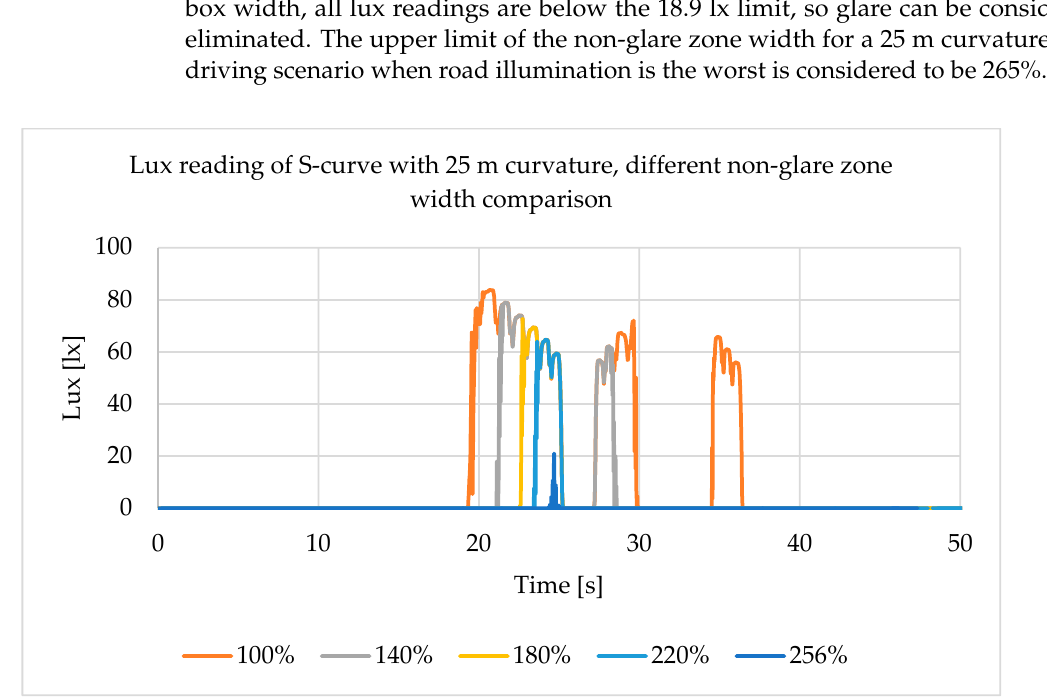
Figure 10. Lux reading of S-curve with 25 m curvature simulation in different non-glare zone widths, showing the trend of reduction in glare with increasing non-glare zone width.